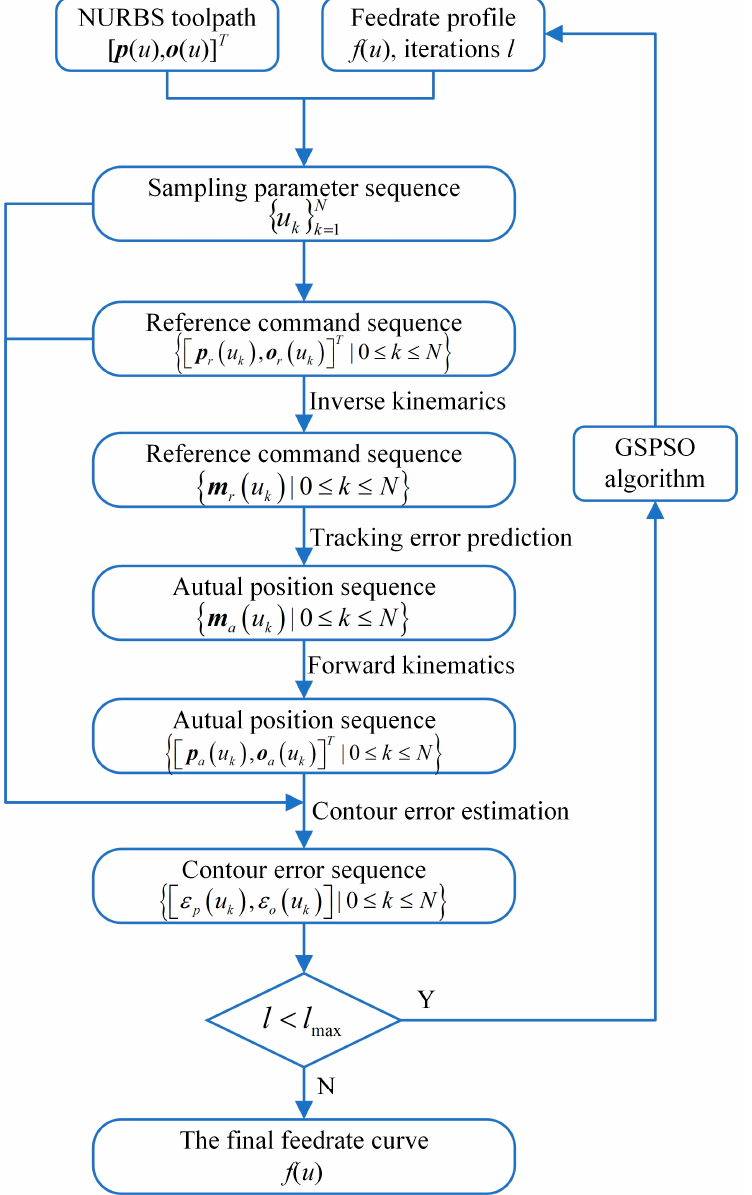
Figure 4. Flow chart of feedrate curve optimization in the current window.